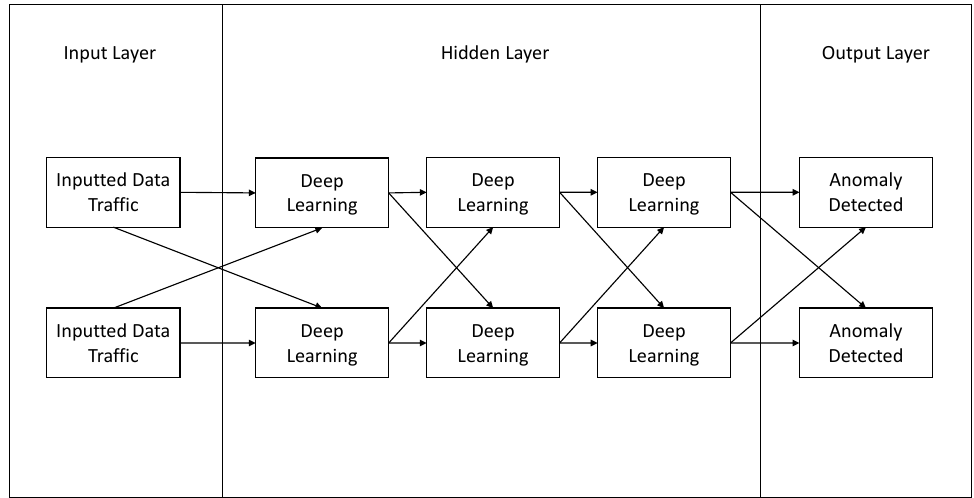
Figure 2. Neural Networks for botnet